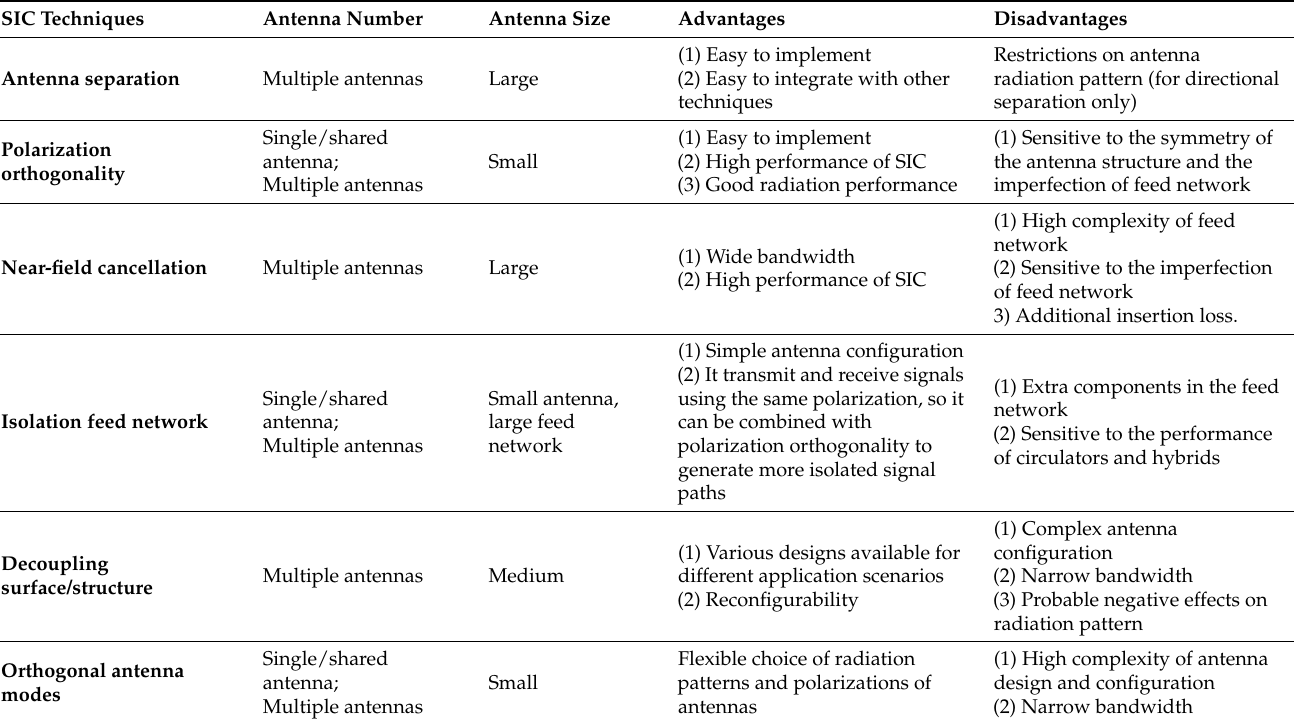
Table 5. Comparison of different IBFD SIC techniques in the AP